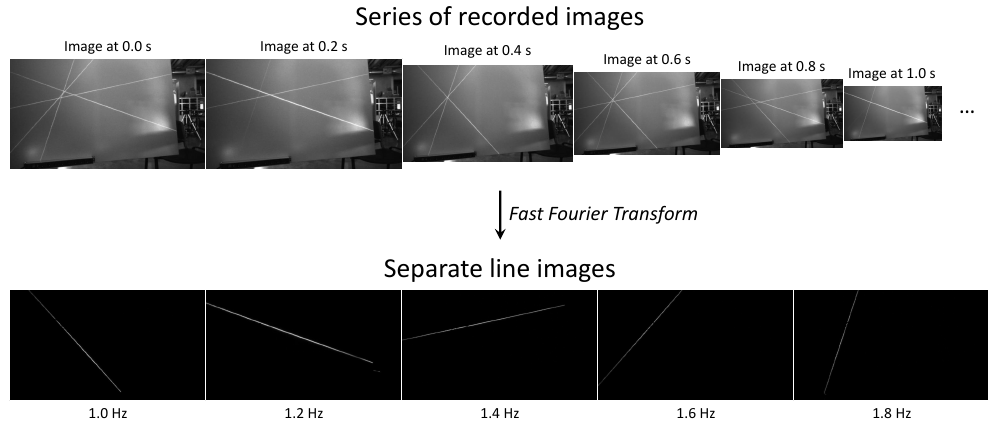
Figure 3. Different lines are projected at different frequencies in a square wave. 100 frames are recorded with a sampling period of 0.2 s. A per-pixel Fast Fourier Transform (FFT) is used to separate the